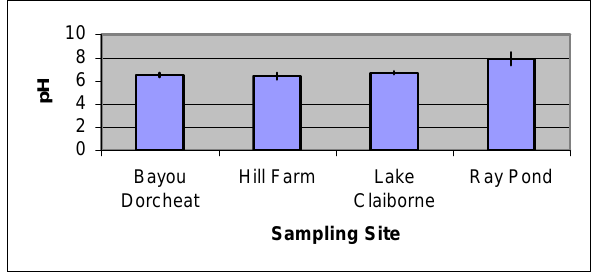
Figure 6: Mean pH values (n=15) for each sampling site.